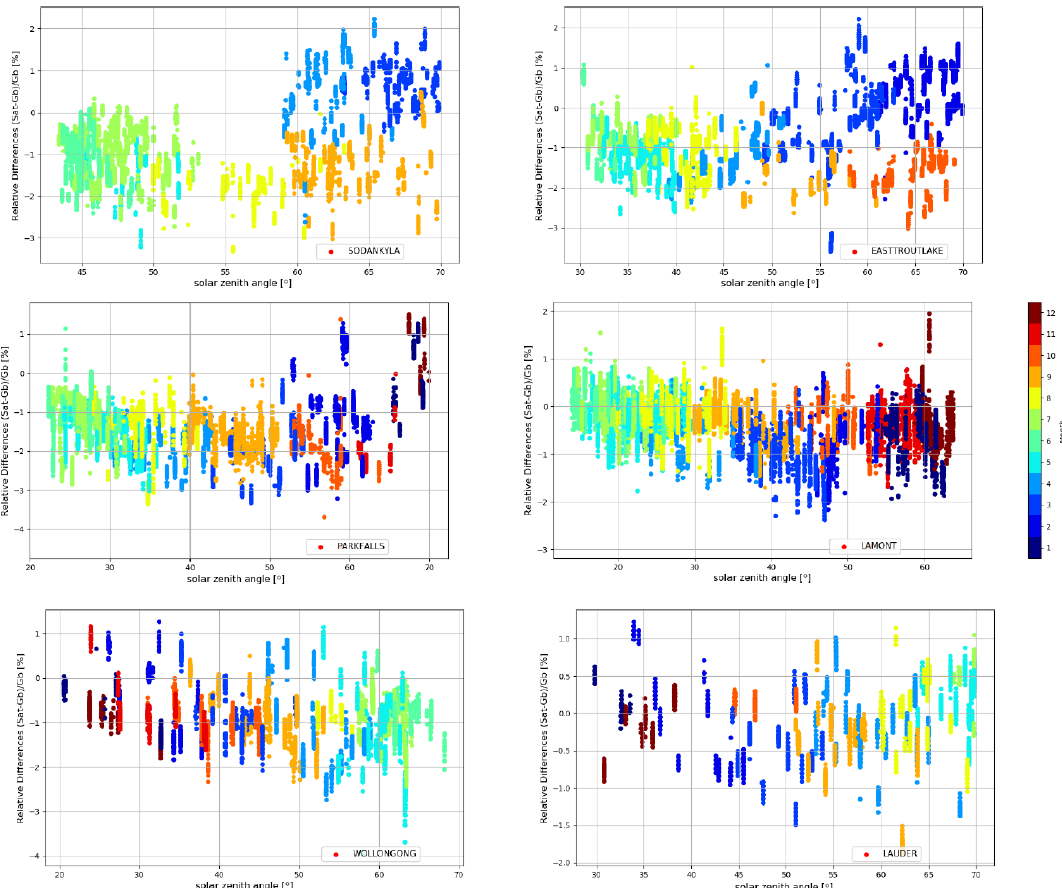
Figure 17. Relative biases between co-located S5P bias-corrected XCH 4 and TCCON XCH 4 data with a priori alignment are plotted as a function of the S5P measurement solar zenith angles retrieved at a few TCCON stations within the period between November 2017 and September 2020. Spatial co-location with radius of 100km and time of ± 1h around the satellite overpass was used. The colours represent the different months from January (1) until December (12) of a